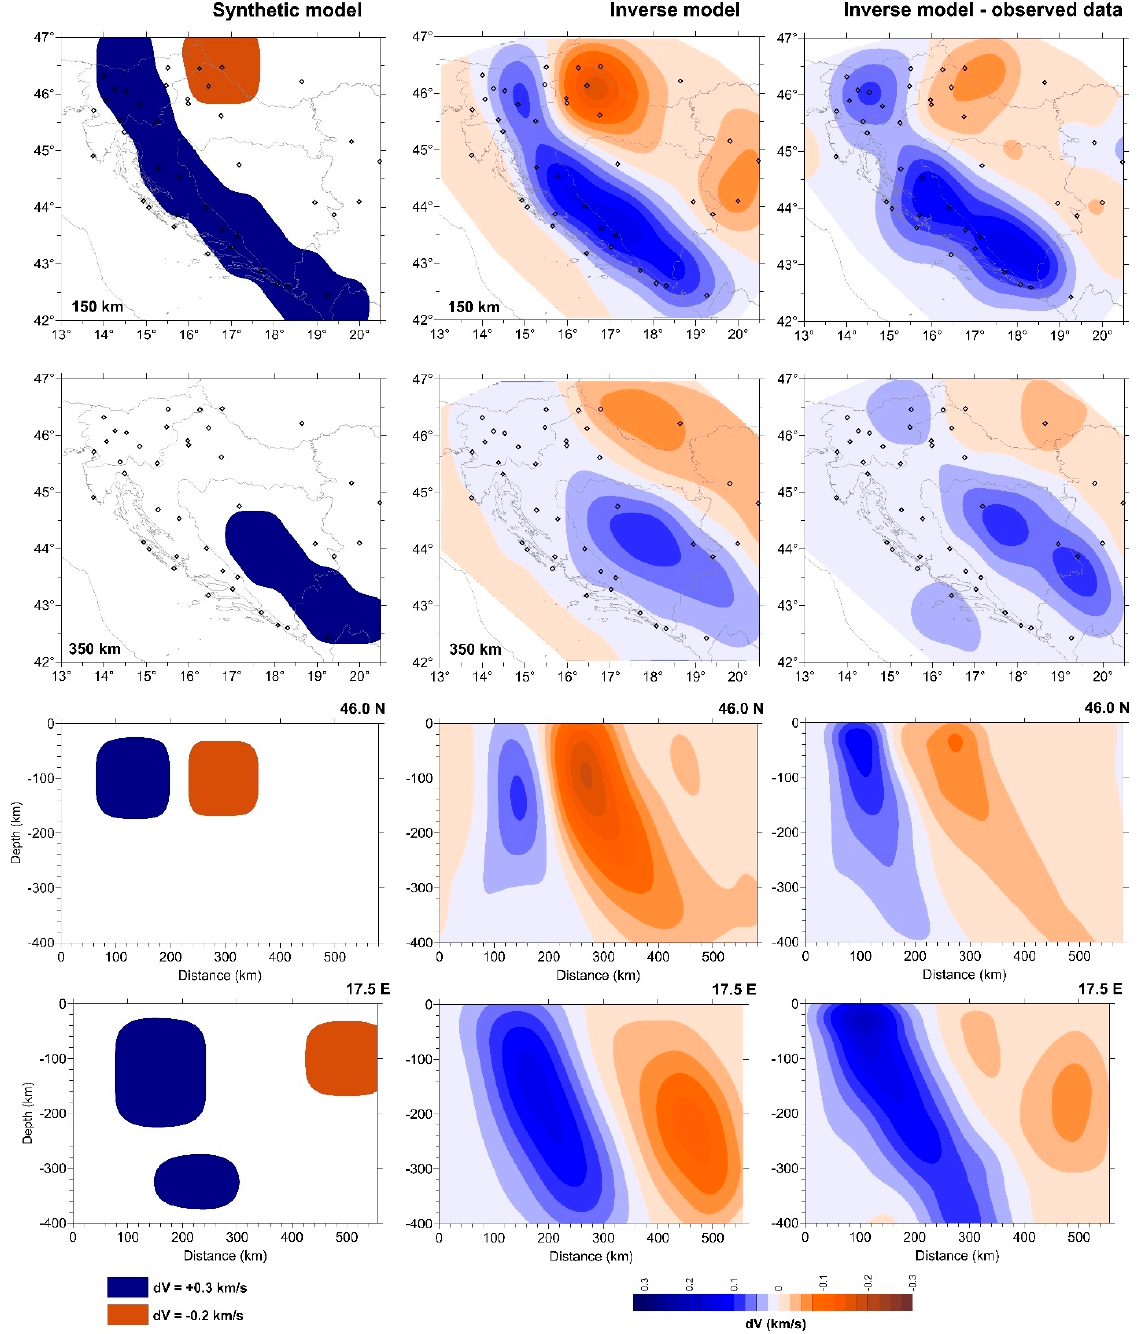
Figure 7. Third model. Three-dimensional velocity models showing two depth slices (150 km and 350 km, upper part) and two cross sections (46 °N and 17.5 °E, lower part). A shallow high-velocity vertical slab in the synthetic model is assumed in the Northern Dinarides, while deep slab in the Southern Dinarides is divided into two separate blocks, the shallow one and the deep one (left side). The inverse model recovered from synthetic travel-time residuals is shown in the middle part, and the inverse model of observed travel-time residuals in the SU-model [8] is shown in the right side. The correlation between the shapes of the anomalies of the inverse and the observed models is similar (profile 17.5 °E) to the second model (Figure 6). Discontinuity in the slab along its depth is difficult to determine due to poor vertical resolution of the method, and deep fast anomaly in the Southern Dinarides cannot be unambiguously